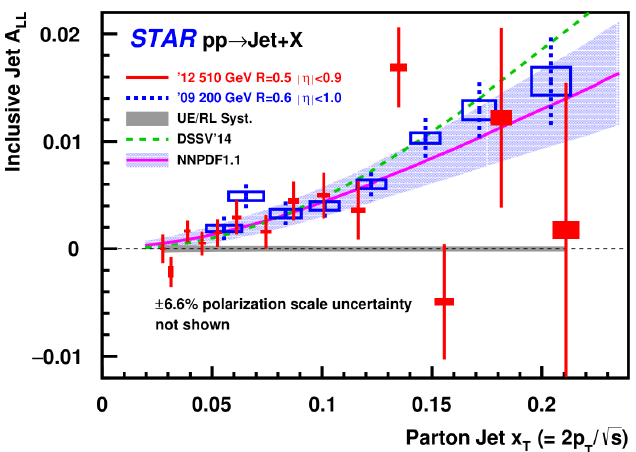
Figure 2: A for inclusive jets with | η | < 0.9 versus x at the parton level. The LL T filled red markers show the 2012 data at 510 GeV from [ 13 ] , whereas the open blue markers show the 2009 data at 200 GeV from [ 1 ] . The error-bars show the size of the statistical uncertainties, whereas the boxes indicate the size of the systematic uncertainties. The gray band on the horizontal axis represent the common relative luminosity uncertainty. The curves show the expected A values for the DSSV14 [ 2 ] LL and NNPDFpol1.1 [ 3 ] parton